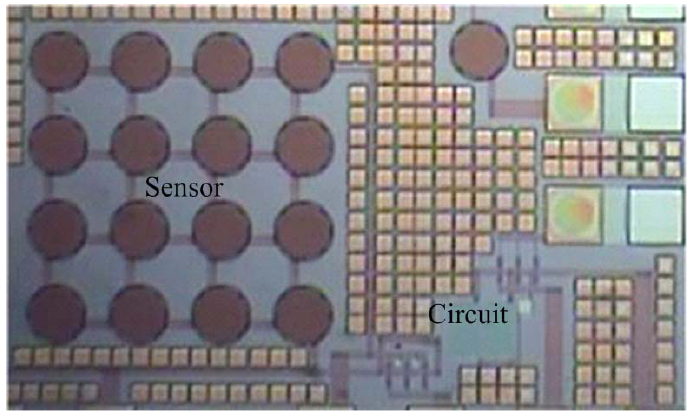
Figure 8. Photograph of the pressure sensor after the wet etching